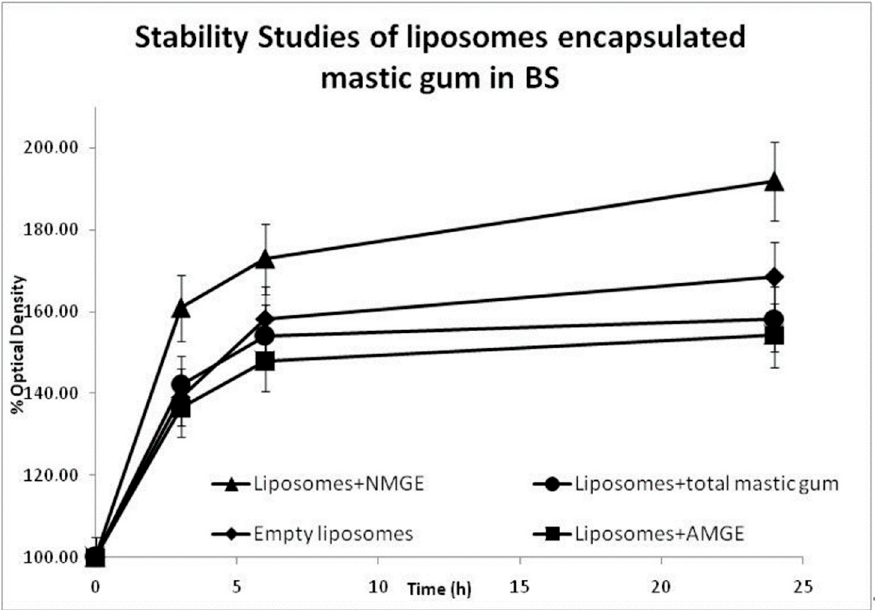
Figure 2. Stability of liposomes encapsulated mastic gum extracts in BS (bile solution). AMGE: acidic mastic gum extract; NMGE: neutral mastic gum extract.